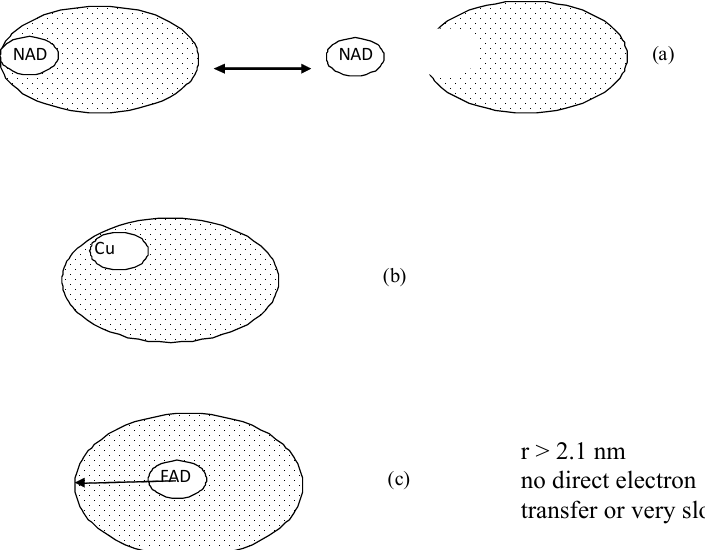
Figure 2. Three groups of enzymes based on location of enzyme active centre (A) Diffusive active centre (B) Active centre located on the periphery of the enzyme, (C) Strongly bound and deep buried redox centres